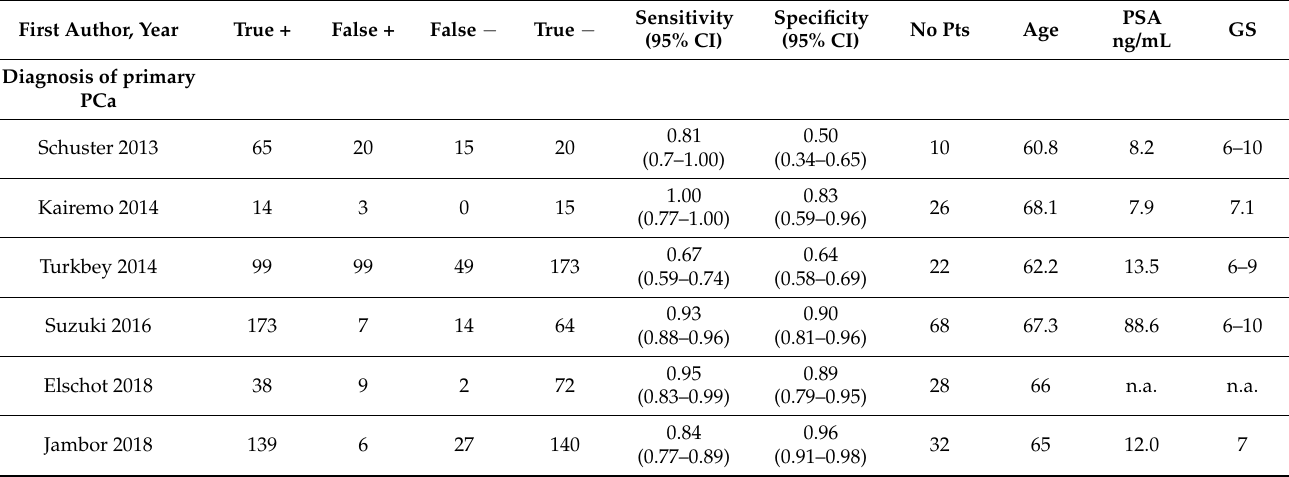
Table 2. Authors, patients, and study characteristics.